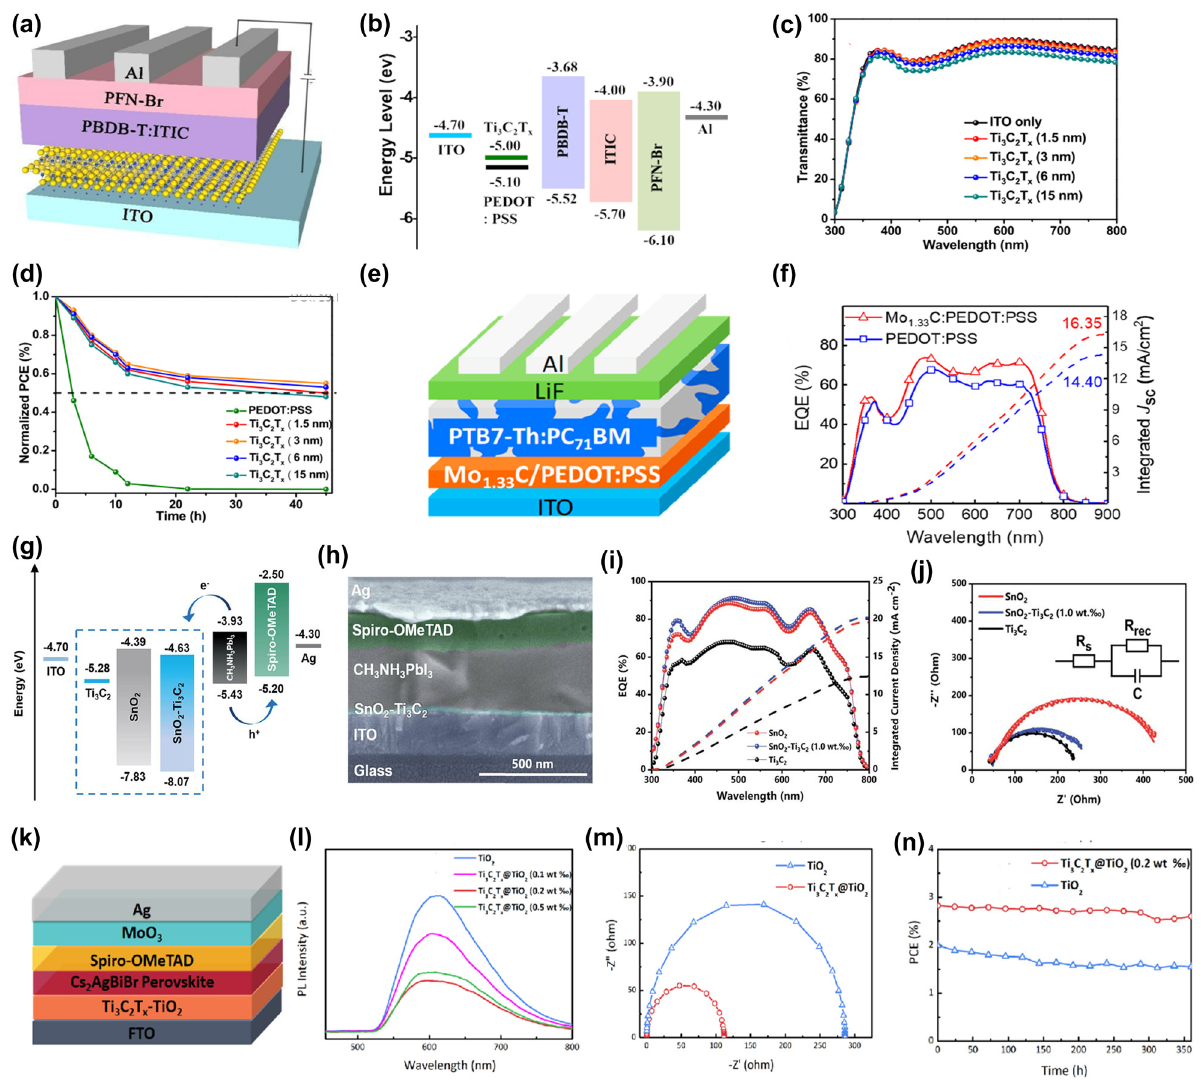
Figure 11: Schematic and properties of the PSC architecture. (a) Schematic of the PSC architecture. (b) Energy band diagrams of used materials. (c) Transmittance spectra of ITO, Ti (3 nm), Ti C T (6 nm), and Ti C T (15 nm) films deposited on ITO substrates. (d) Stability of devices with different HTLs under atmosphere 3 2 3 2 x x conditions without any encapsulation; Reproduced with permission [172]. Copyright 2019, Royal Society of Chemistry. (e) Schematic diagram of PSC structure and composition of the HTL. (f) EQE and integrated Jsc of PSCs using pristine and Mo HTL. Reproduced with permission [173]. Copyright 2020, Royal Society of Chemistry. (g) Schematic energy-level diagram of each layer. (h) Cross-sectional SEM image of the PSC device. (i) EQE spectra and the corresponding integrated current densities for the representative PSCs , SnO –Ti C (1.0 wt%) and Ti C , respectively. (j) Nyquist plots of the PSCs with SnO fabricated with SnO 2 2 3 2 3 2 as ETLs under one sun illumination. Reproduced with permission [174]. Copyright 2019, Royal Society of Chemistry. (k) Schematic diagram of AgBiBr solar cell structure. (l) PL spectra of Cs AgBiBr perovskite films deposited on Ti planar Cs 2 6 2 6 Ti C T @TiO (0.2 wt %) and TiO based PSCs. (n) Ambient stability characteristics of the PSCs based on TiO 3 2 2 2 x under simulated AM 1.5 sunlight of 100 mW/cm 2 irradiance. Reproduced with permission [175]. Copyright 2021, American Chemical